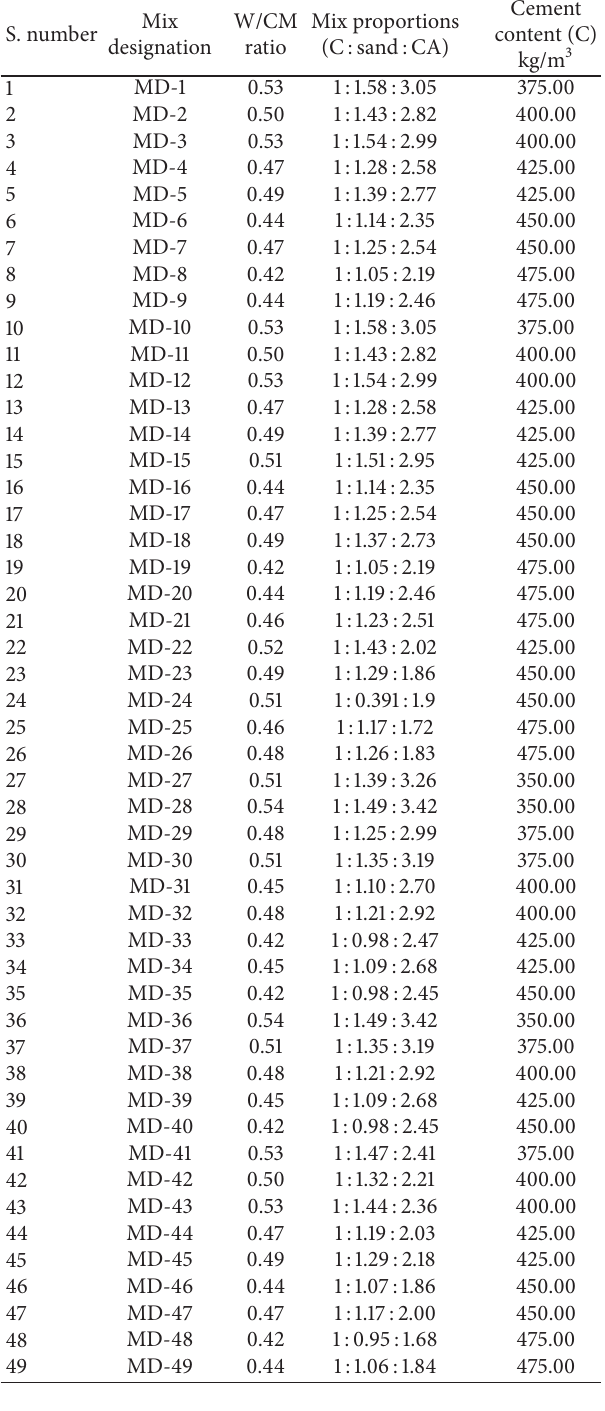
Table 1: Details of proportions for concrete mixes without fly